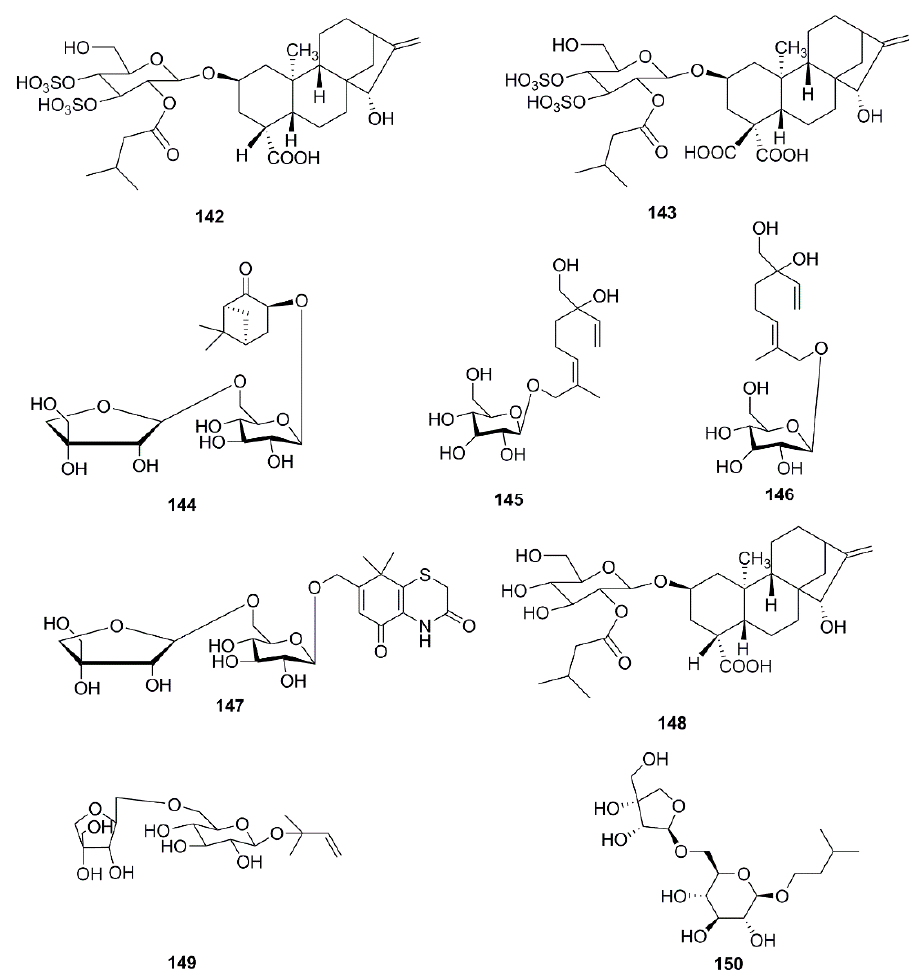
Figure 8. Chemical structures of the glycosides in X. strumarium.